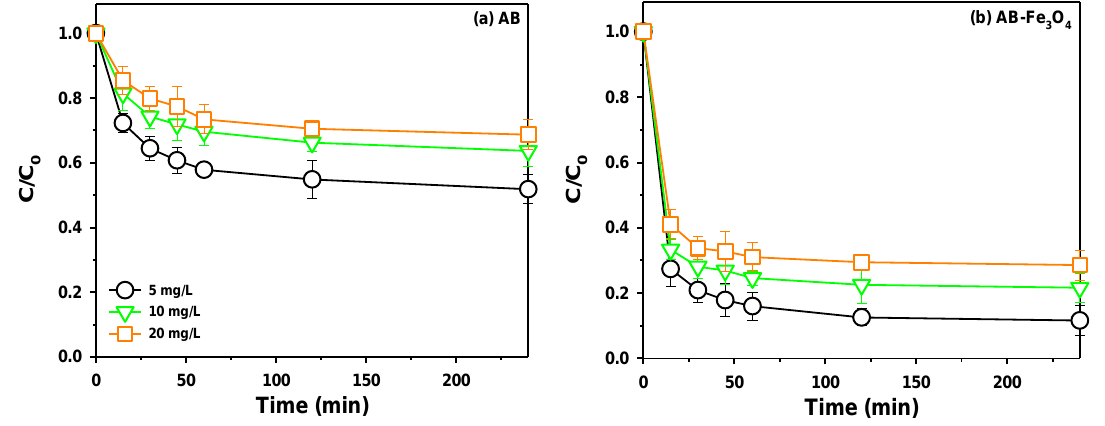
Figure 8. Effect of initial TeCP concentration and contact time on adsorption of TeCP by ( a ) AB and ( b ) AB-Fe 3 O 4 at pH 3.5 ( V = 30 mL, adsorbent mass 30 mg, agitation speed = 300 rpm, temperature = 25 ± 1°C, and reaction time = 120 min).